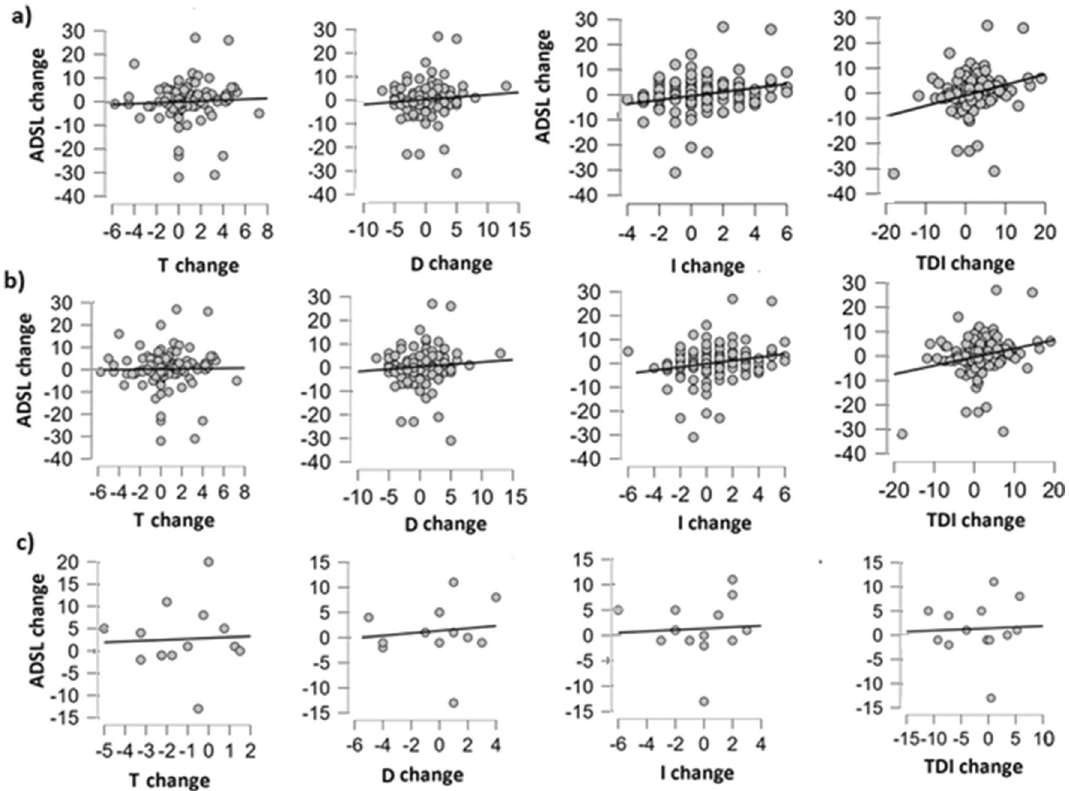
Figure 4. Classical Pearson one-way correlation between, respectively, the change in T, D, I and TDI score and depression severity (ADSL) score for ( a ) the group of dysosmic patients; ( b ) the whole group; ( c ) the group of normosmic